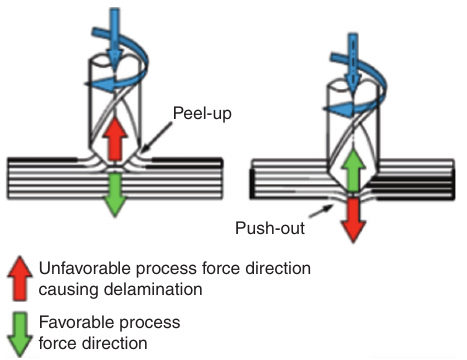
Figure 1 Schematic of delamination mechanisms (peel-up and push-out) as well as the favorable axial process force